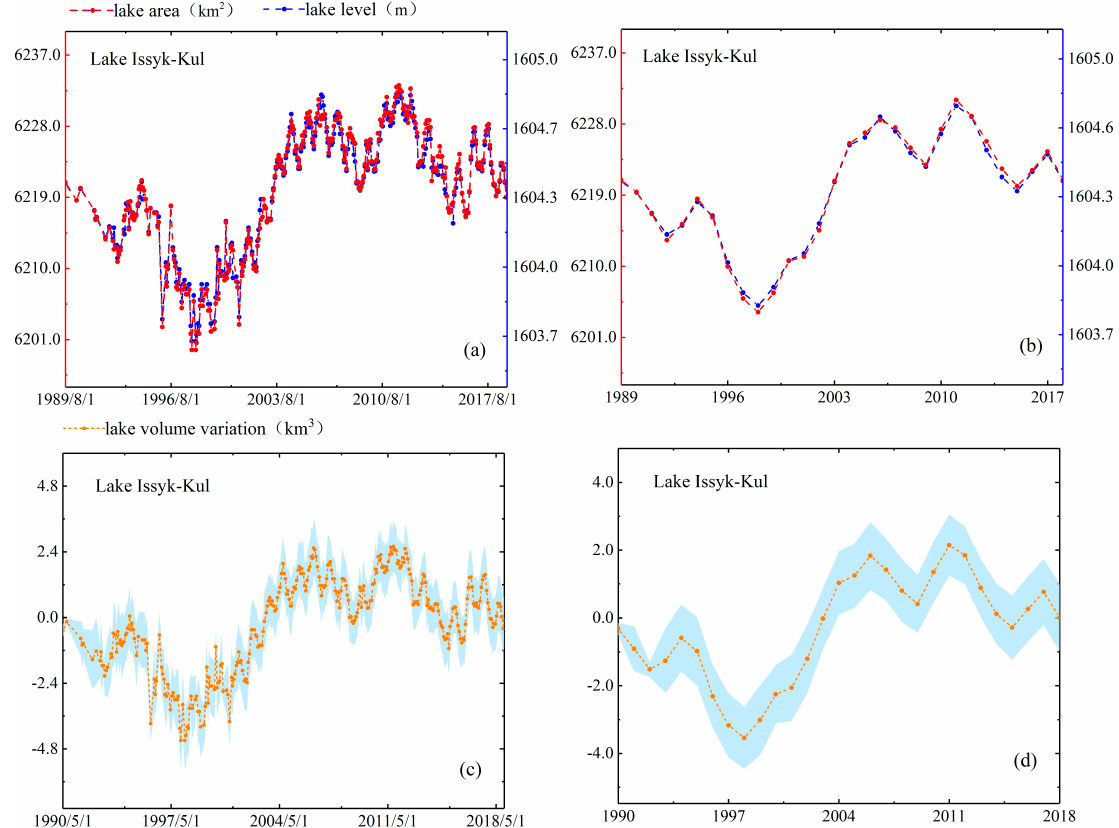
Figure 8. Lake area, level and volume variations in monthly ( a , c ) and annual ( b , d ) timescales for Lake Issyk-Kul. Lake